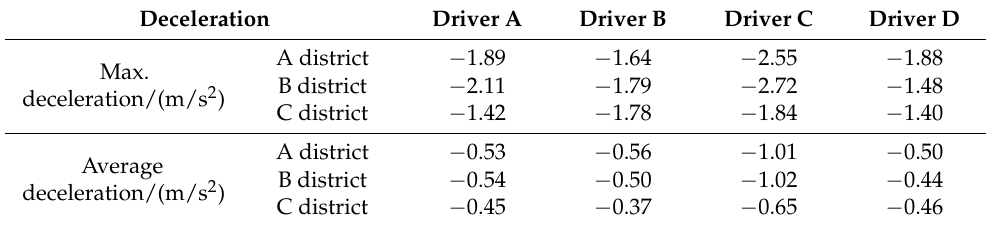
Table 6. Deceleration from different drivers.